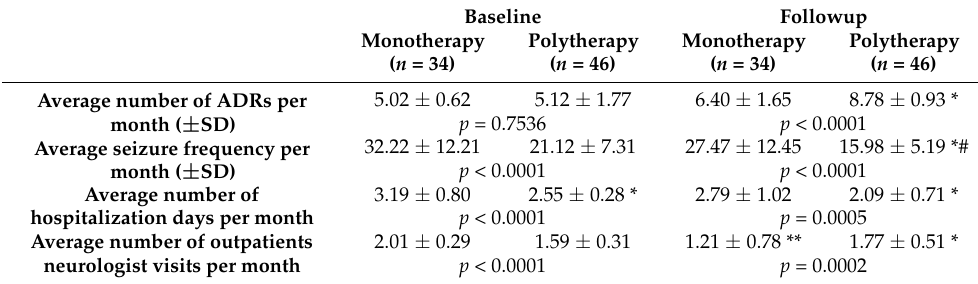
Table 3. Clinical and statistical data of pediatric patients with epilepsy.